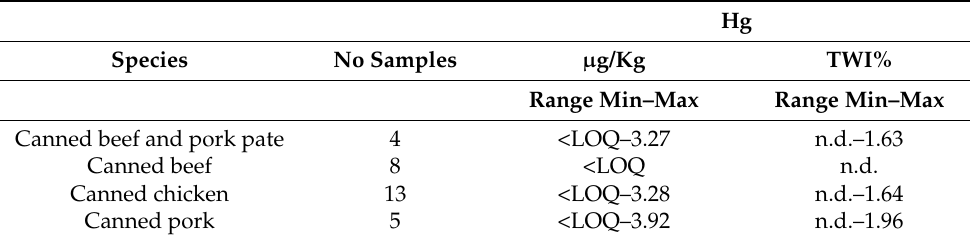
Table 4. Tolerable weekly intake (TWI) % values for Hg contents in analyzed processed